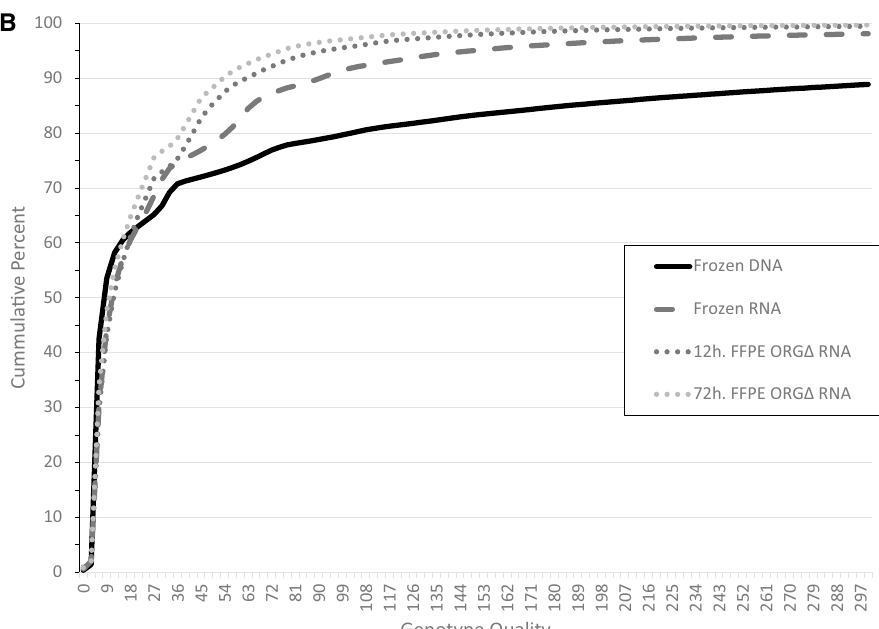
Figure 1. Influence of organocatalyst (ORG∆) treatment on cumulative percent SNP genotype quality (GQ) scores. GQ scores for the indicated sets of samples were extracted from the VCF files generated by GATK. The percent of SNPs for each sample type scoring at or below the indicated scores on the x-axis are displayed on the y-axis. ( A ) SNP GQ scores from DNA samples that had been frozen (FR) or formalin-fixed for 12-h or 72-h (FFPE), with or without ORG∆. ( B ) SNP GQ scores from FR DNA, FR RNA, ORG∆-treated 12-h FFPE RNA, and ORG∆-treated 72-h FFPE RNA samples. The FR and 12-h FFPE samples used sections from kidney and ovary tumors, whereas 72-h FFPE samples used sections from only the ovary